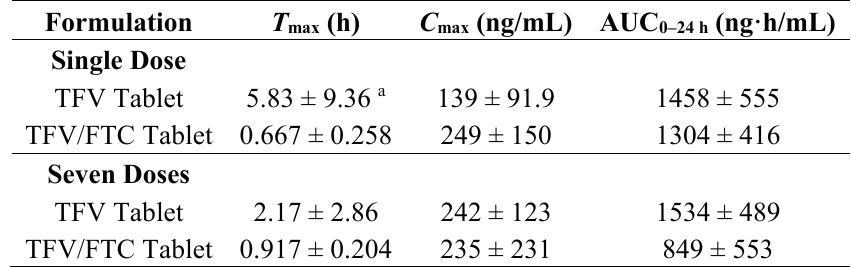
Table 3. TFV plasma PK parameters following intravaginal administration of intact TFV tablets (10 mg), or TFV/FTC tablets (10 mg/10 mg), after a single dose and seven once-daily doses (Study 2).